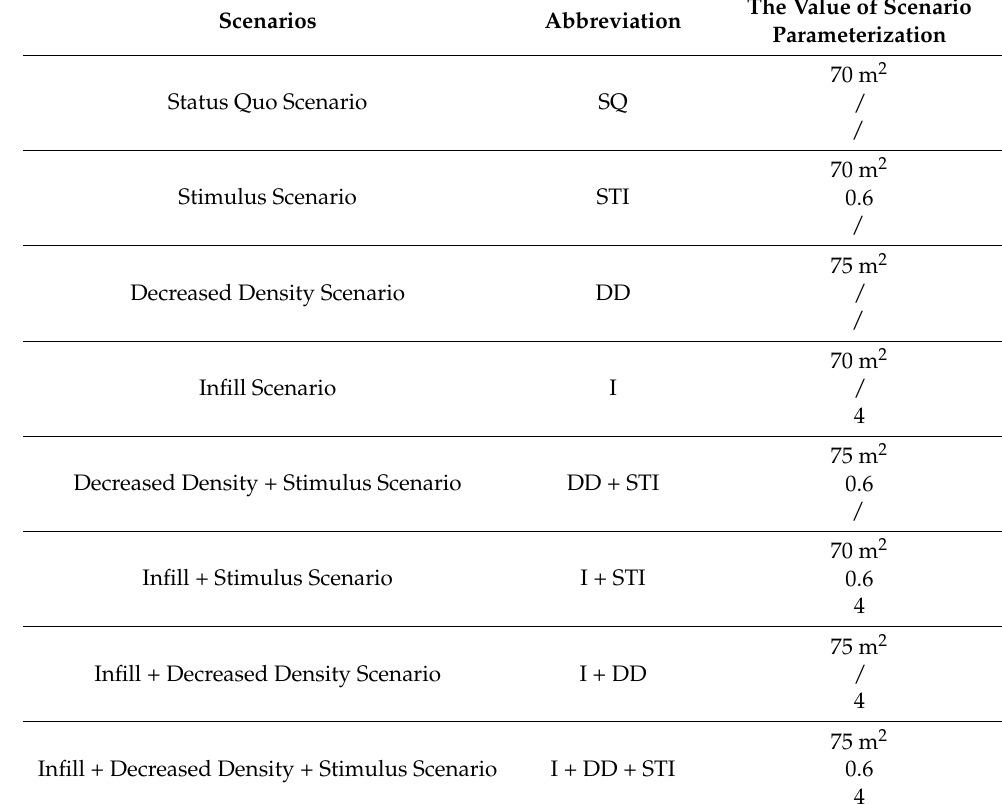
Table 3. Base scenarios, scenario combinations, and their